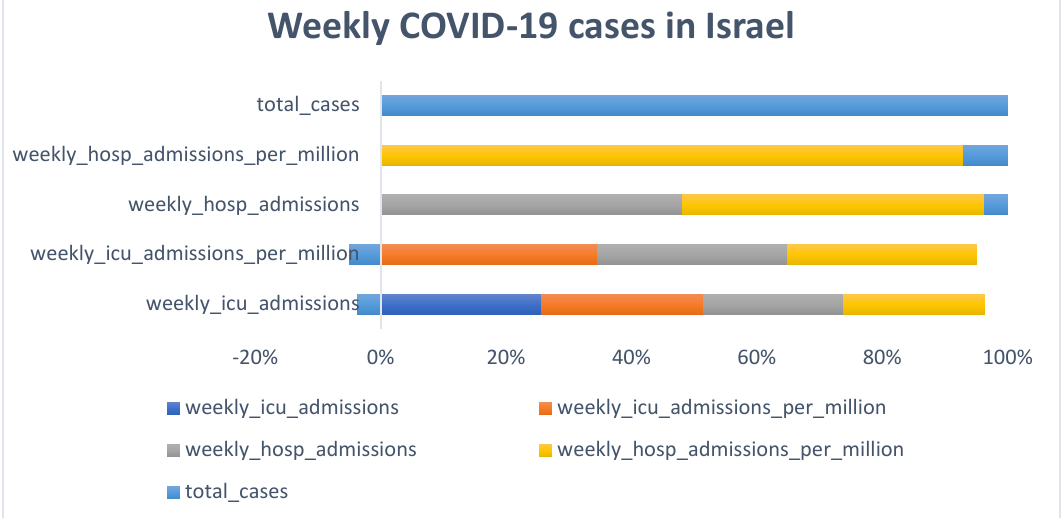
Figure 4. Weekly COVID-19 cases in Israel.